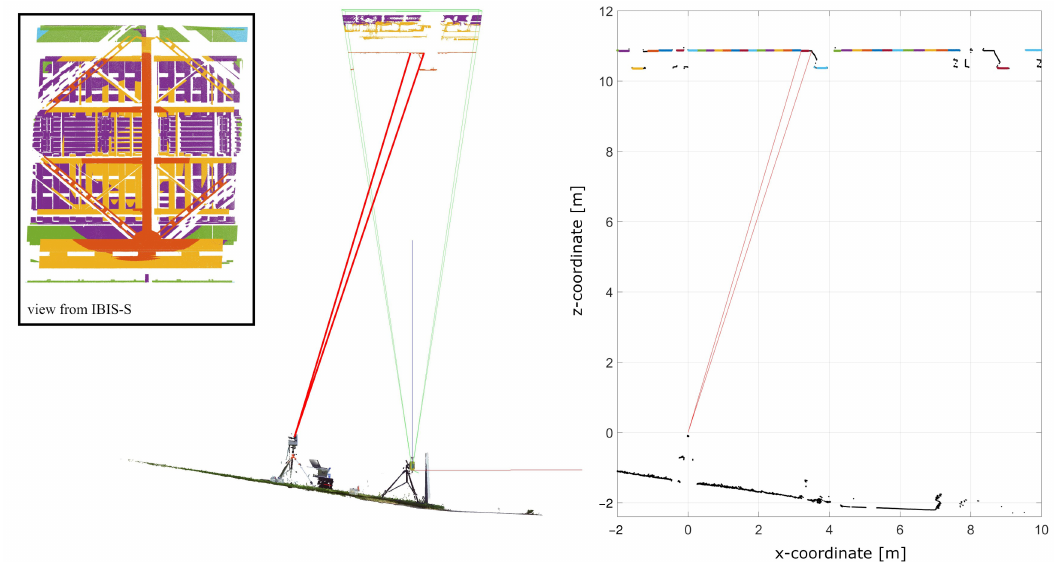
Figure 9. Measurement configuration of IBIS-S and IMAGER 5016 in profile mode for setup 1. On the left side a 3D scan of both sensors is shown, including the color coded (range bins) view of the bridge underside from the IBIS-S. On the right side a cutout of a processed profile of the IMAGER 5016 is shown, which is color coded based on the spatio-temporal processing scheme from